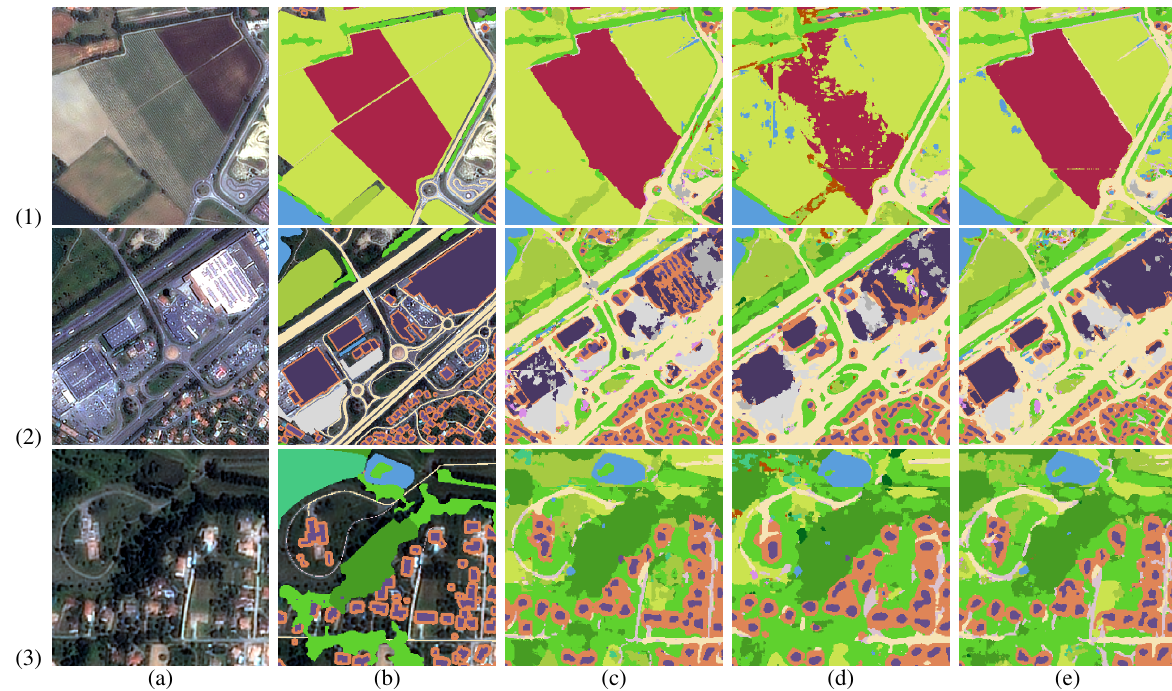
Figure 3. Rows : (1) Vineyards, (2) Industrial and commercial area, (3) Paths in diffuse urban area. Columns : (a) SPOT image, (b) Ground truth, (c) SPOT inference, (d) S2 inference, (e) Fusion inference